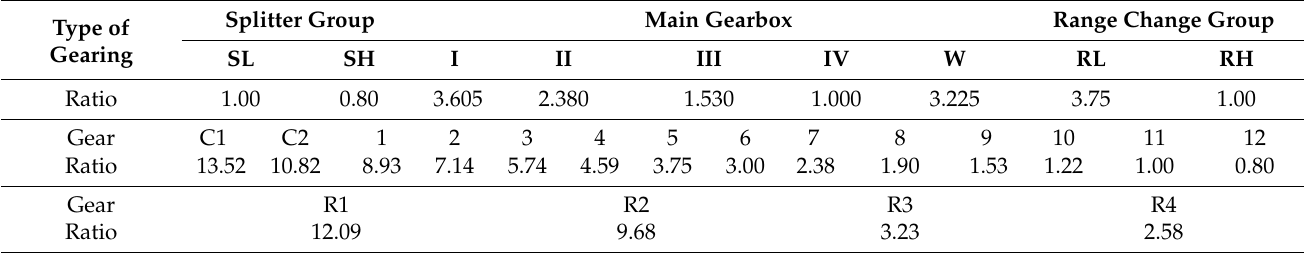
Figure 5. Schematic diagram of the VTO2214B gearbox design system [34]: 1—Splitter Group gearbox, 2—main gearbox, 3—Range Change Group gearbox, Split High—(SH, i = 0.80), Split Low—(SL, i = 1.00), High Range—(HR, i = 1.00), Low Range—(LR, i = 3.75). Table 3. Identification of the gear ratios of the VTO2214B